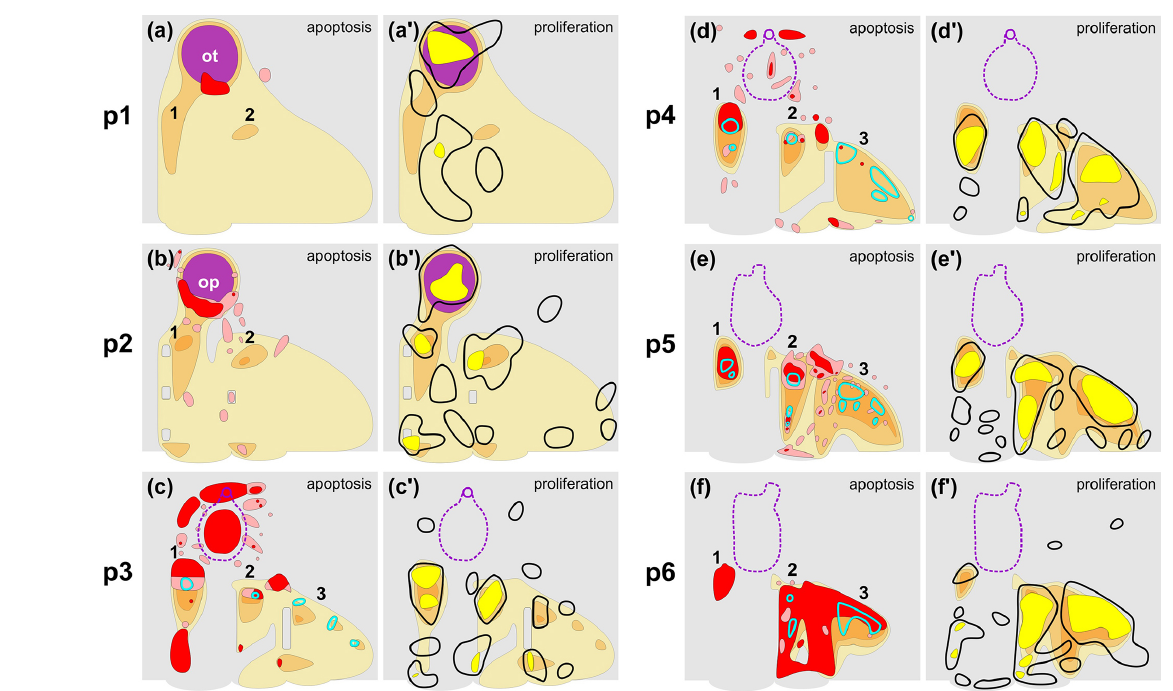
Figure 20. Apoptosis, proliferation, and neuroblast delamination in the epibranchial placodes of Tupaia belangeri . Schemes derived from 3-D reconstructed embryos of phases 1 to 6 (p1–p6) of ocular development: surface ectoderm (gray), three grades of ectodermal thickenings (light yellow: at least cylindrical; light orange: at least pseudostratified; orange: pseudostratified with at least three rows of nuclei), otic placode (ot) or pit (op; violet), projection of otic vesicle (dashed violet line), attachment site of otic vesicle (violet circle), apoptotic cells on one (light red) or both sides (red) of the embryonic body, hot spots of proliferation on one (thick black lines) or both sides (yellow) of the embryonic body, delaminating placodal neuroblasts (light blue). (a–f) Apoptotic events proceed rostrocaudally and contribute to the individualization of otic and epibranchial placodes (1, 2, 3) from their combined anlagen. In structurally demarcated epibranchial placodes, apoptosis first assists in the “selection” of premigratory placodal cells and, finally, in the regression of the placodes. (a’–f’) Preceeding neuroblast delamination as well as apoptosis, a rostrocaudal wave of proliferation passes through the anlagen of the placodes. Reprinted from Washausen et al. (2005, Fig. 7). © 2004, with permission from